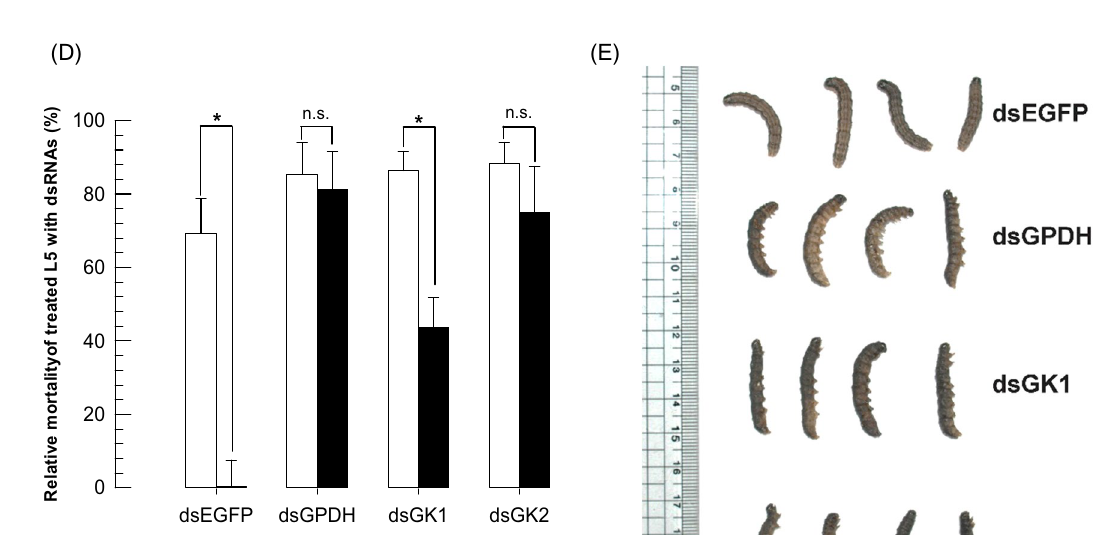
Trehalose (mM)/hemolymph of fifth